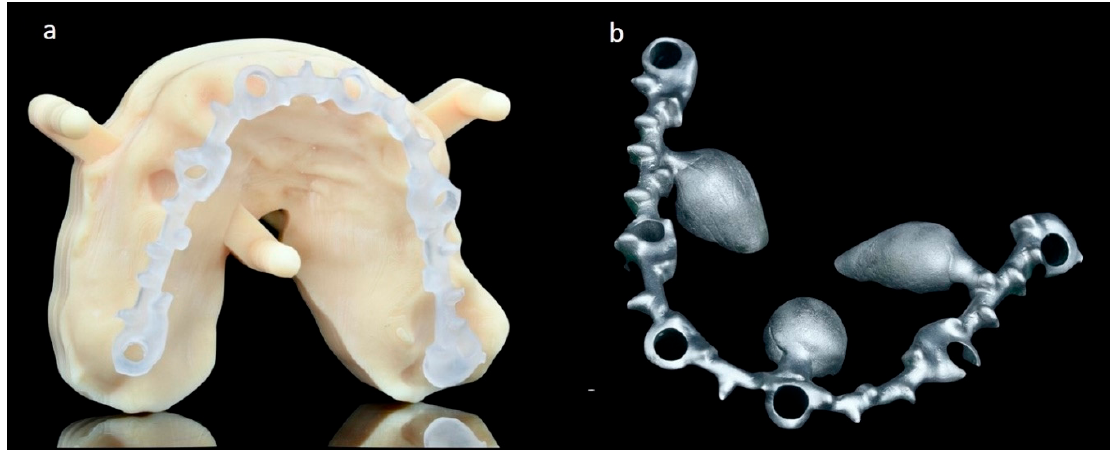
Figure 6. The framework printed in resin after digital planning ( a ) and the metallic melted one ( b ).